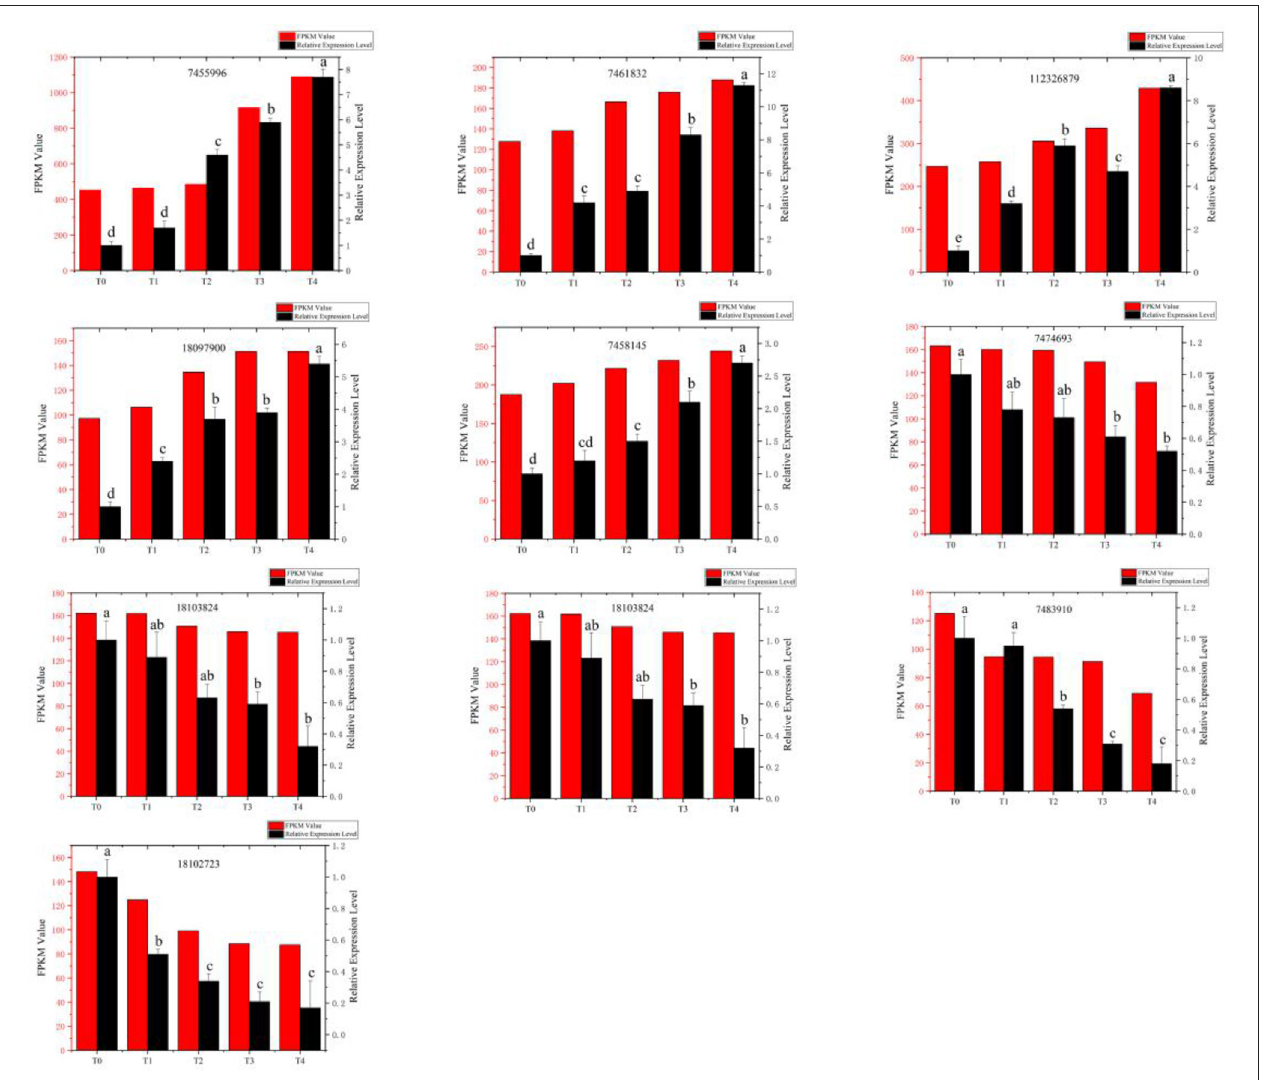
FIGURE 3 | Comparison of relative expression of differential genes detected by RNA-Seq and quantitative real-time polymerase chain reaction (qRT-PCR). Red bars: The change in the fragments per kilobase million (FPKM) value obtained by RNA sequencing (left vertical axis). Black bars: The relative expression level (right vertical axis) obtained by qRT-PCR experiment. T0, T1, T2, T3, and T4 stand for the Fusarium oxysporum -treated Pdpap by 0, 6, 12, 24, and 48h,